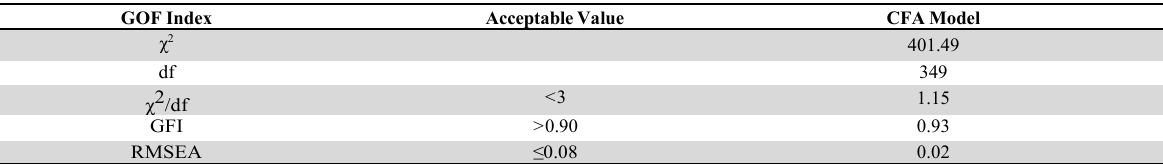
CFA test GOF Index Acceptable